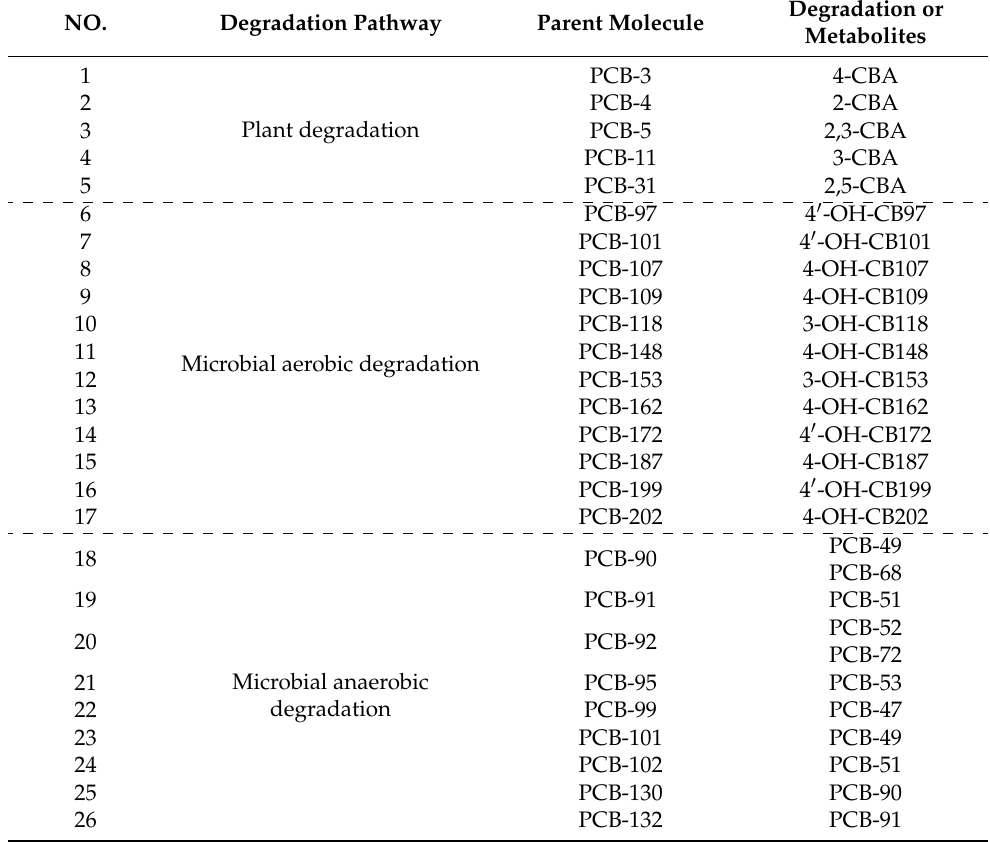
Table 1. Summary of the degradation or metabolites of the PCBs [7,24,29–31]. NO. Degradation Pathway Parent Molecule